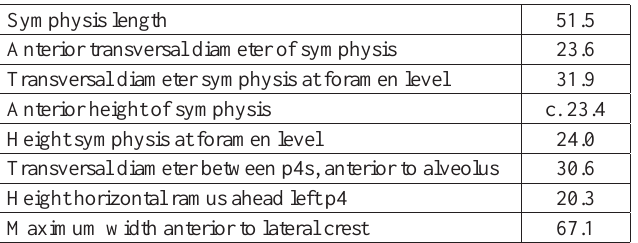
Table 2. Mandibular dimensions (in mm) of Cardiatherium calin- gastaense sp. nov. (INGEO-PV